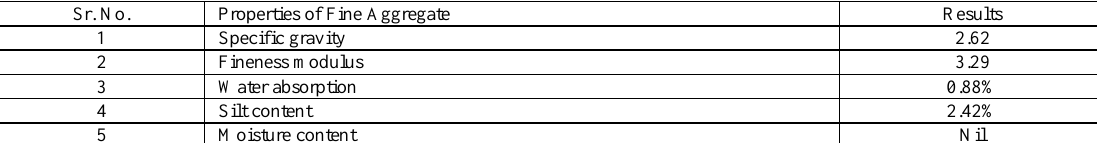
Table 4. Test result of fine aggregate